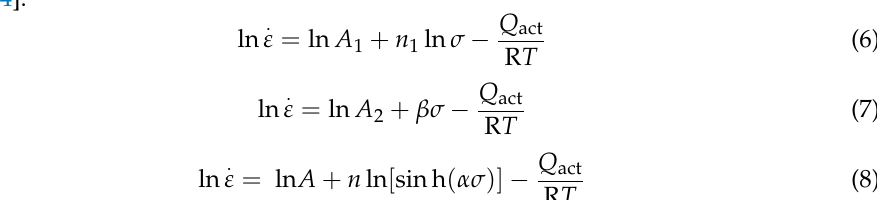
. ε — σ p relation curve are obtained by linear fitting . ε —ln σ relation curve and ln